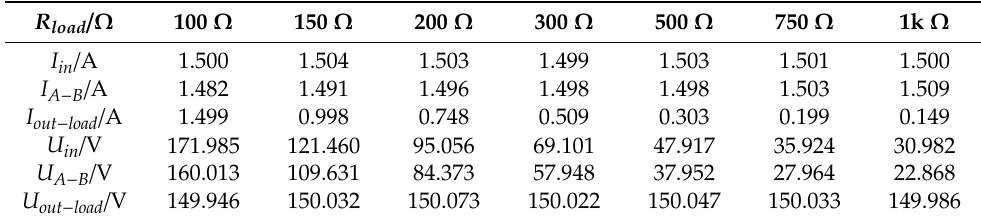
Table 2. Experimental test data in the different resistance values of load.